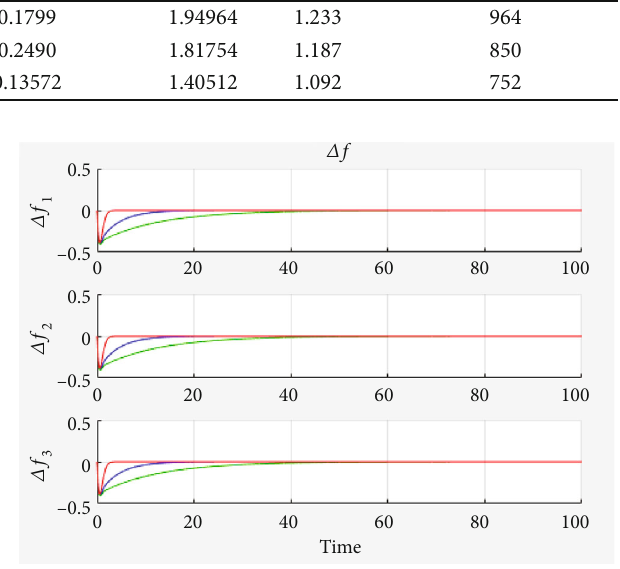
Figure 10: Deviation frequency response of area 1, area 2, and area 3 for constant load